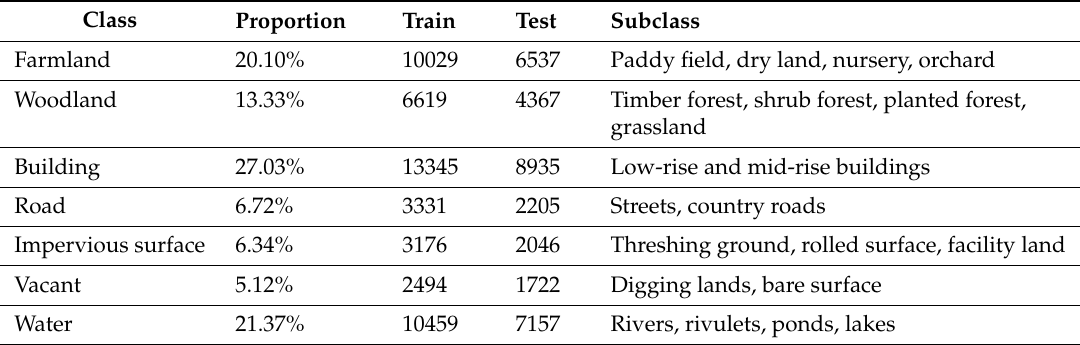
Table 6. Land-cover classes, sample numbers, and subclass descriptions in the Yuecheng dataset.